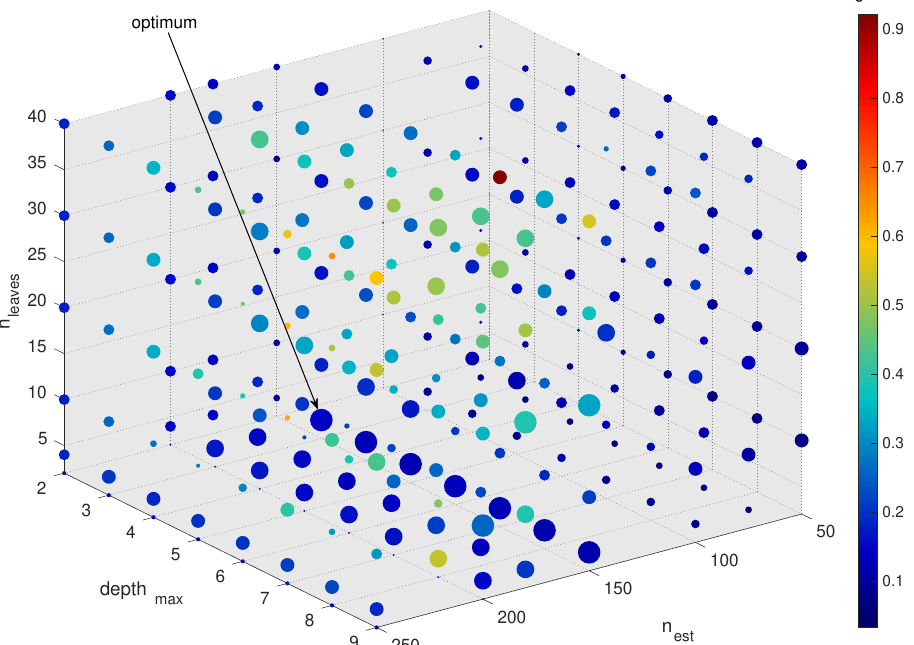
Figure 4. 3D visualization of grid search result over the investigated space of hyperparameters n est , depth max and n leaves . Bubble sizes implicate the validation score (the larger, the better); the color indicates the required training time (the less, the better). The optimum configuration of a LightGBM model is at n est = 150, depth max = 3, and n leaves = 4 at a test accuracy of 0.9815 and a training time of